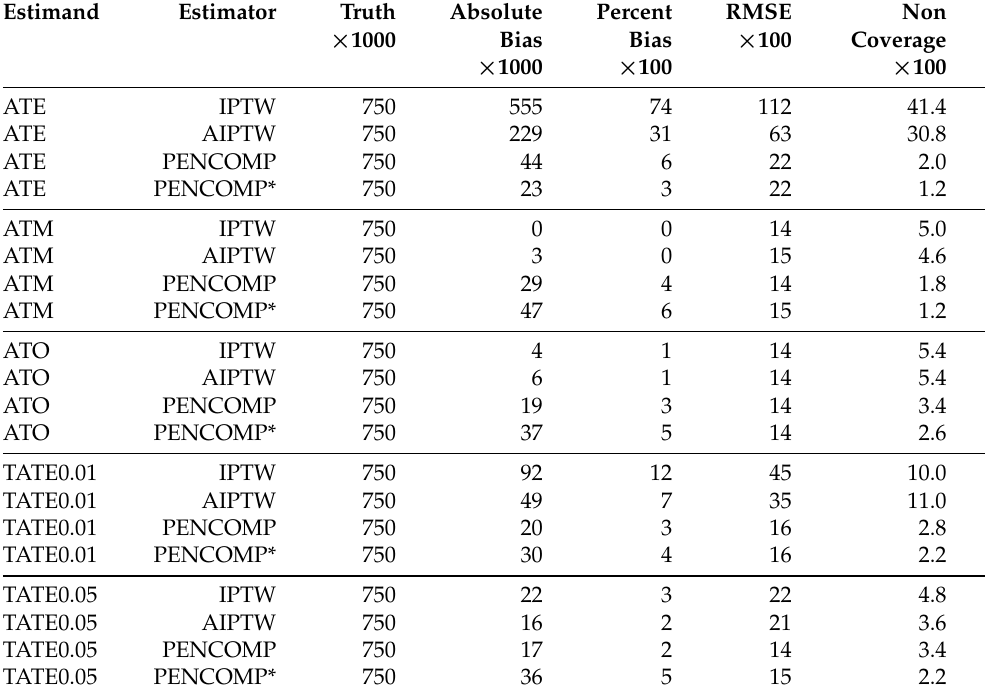
Table 2. Empirical bias (in absolute and percentage), RMSE, and 95% CI (non) coverage, across the methods in a linear and continuous outcome model for the scenario where the outcome models were misspecified. Results were based on 500 simulations with sample size of 500; 500 bootstraps were used to estimate standard errors for the weighted estimators and 200 complete datasets for PENCOMP. PENCOMP* denotes the outcome misspecification with a null outcome model by fitting a penalized spline on the propensity score only. ATE = Average treatment effect; ATM = average treatment effect on an evenly matchable set; ATO = average treatment effect on the overlap population; TATE α = truncated average treatment effect with a truncation at a pre-defined α